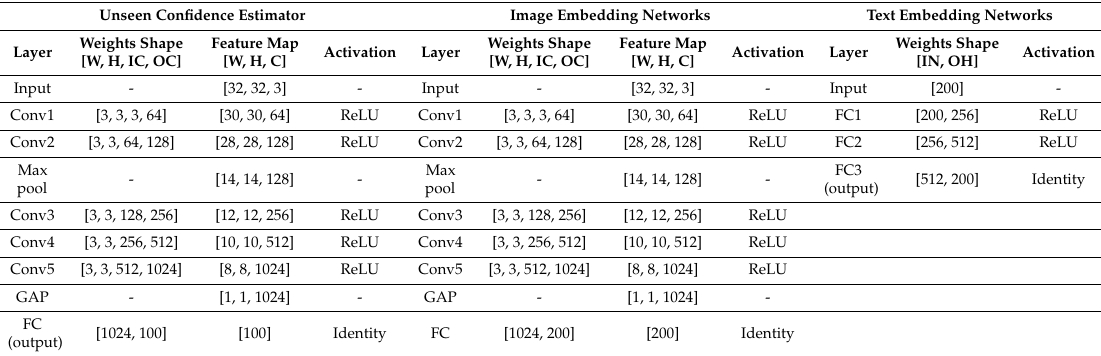
Table 1. Network architecture used in the proposed zero-shot learning model.